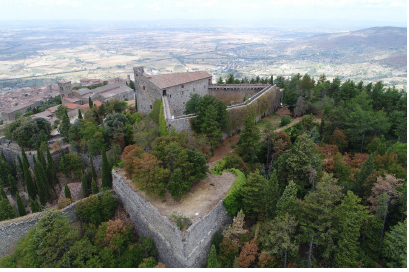
Figure 1. Girifalco fortress, Cortona,